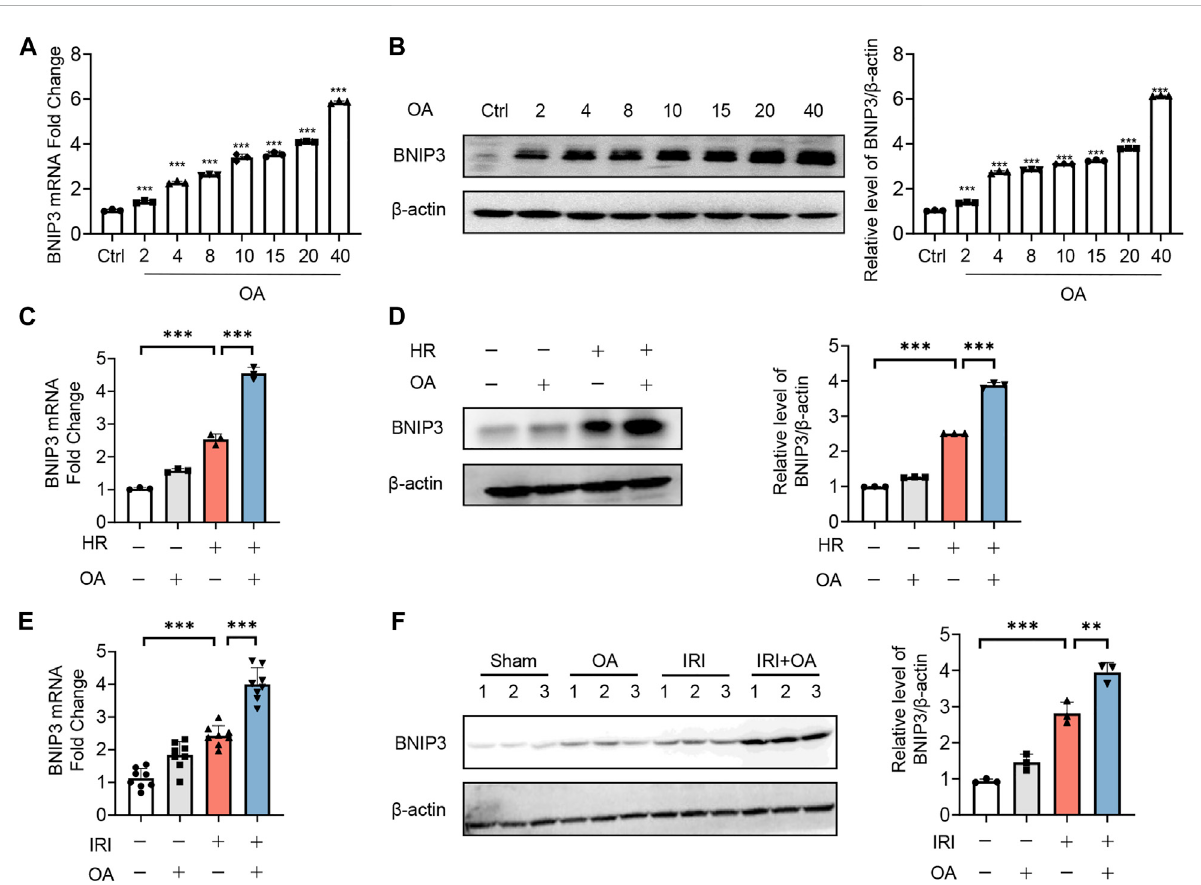
FIGURE 3 OA enhances BNIP3 expression in vitro and in vivo . (A , B) qPCR (A) and Western blot (B) analysis of theexpression of BNIP3 in HK-2 cells treated with OA for 24 h ( n = 3). (C , D) The mRNA and protein expression of BNIP3 in HK-2 cells exposed to HR followed by incubation with control or OA were analyzed by qPCR (C) and Western blot (D) ( n = 3). (E , F) qPCR (E , n = 8 ) and Western blot (F , n = 3 ) analysis of the expression of BNIP3 in kidney tissues from sham and AKI mice treated with control or OA. Data are expressed as means ± SEM. pp P < 0.01, ppp P <